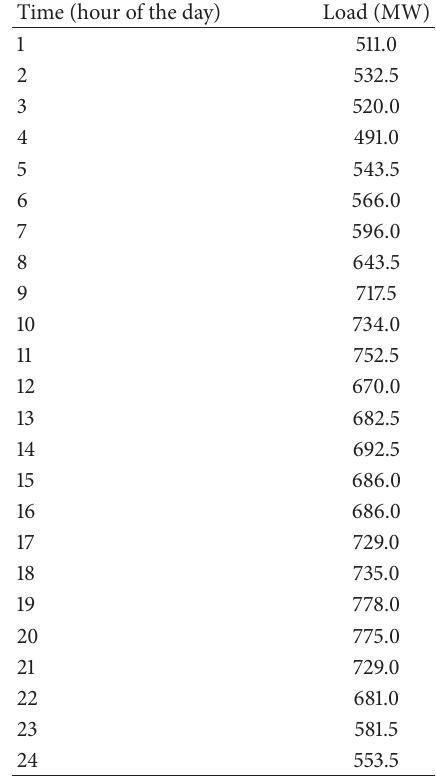
Table 1: Data of the large industrial